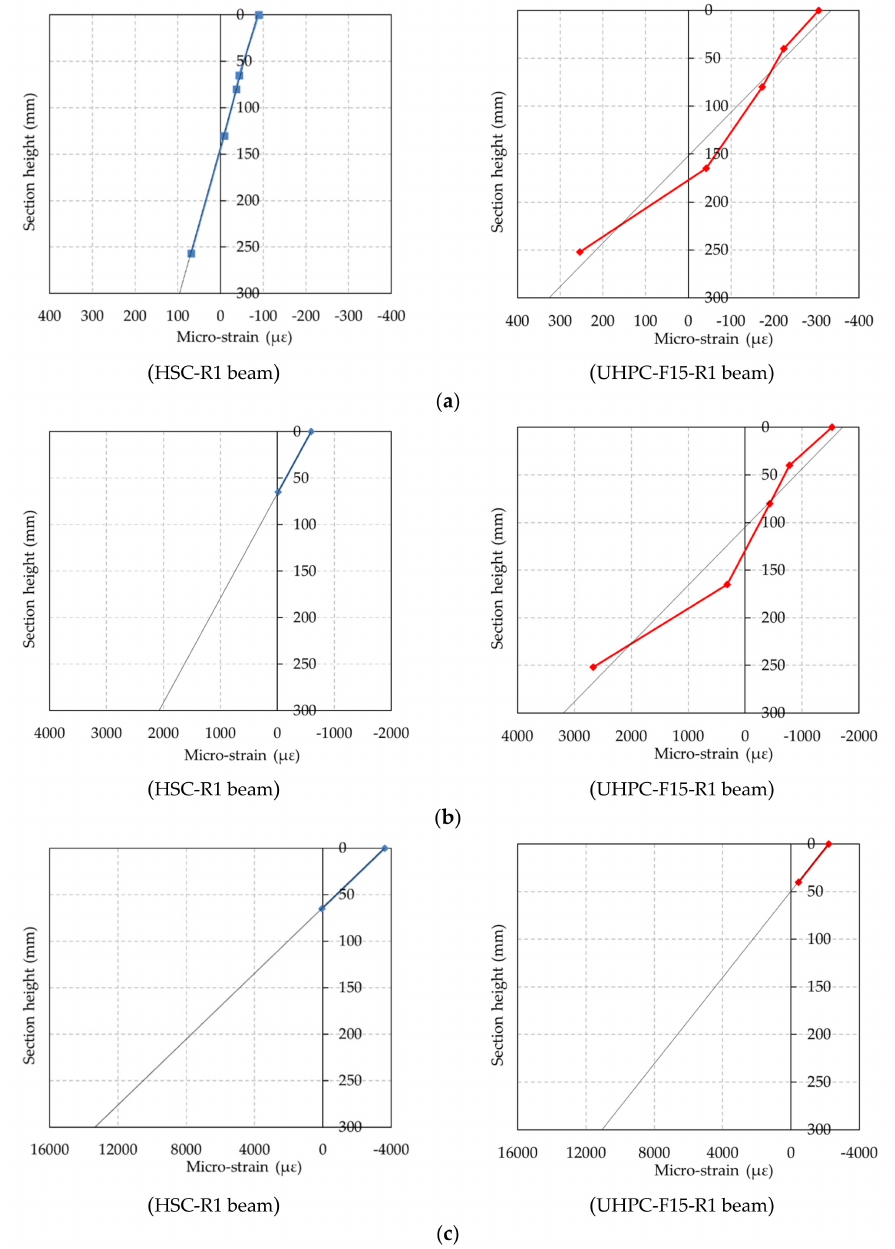
Figure 17. Strain distributions of the UHPC and HSC beams. ( a ) Initial cracking stage, ( b ) Rebar yielding stage, ( c ) Ultimate